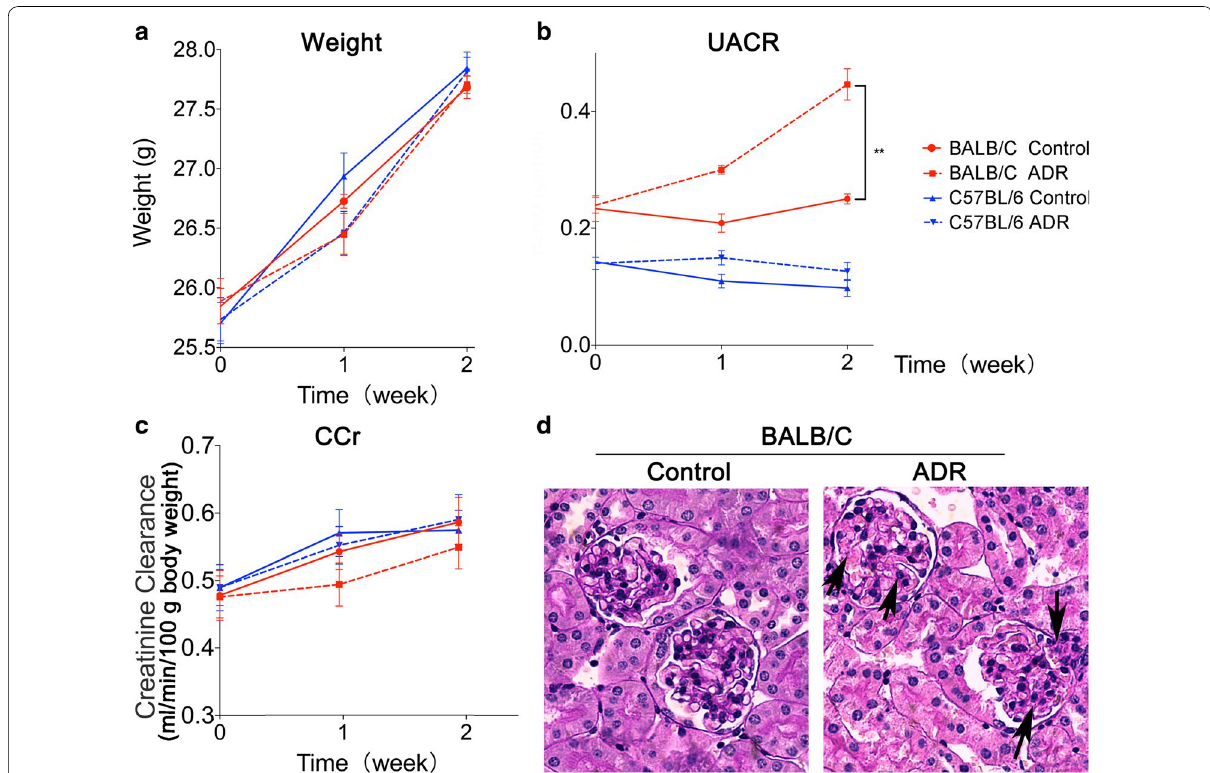
Fig. 1 BALB/C mice were sensitive to ADR. a The weight changes in the control and ADR group of different mice during the 2 weeks; b the UACR changes in the control and ADR group of different mice during the 2 weeks; c the CCr changes in the control and ADR group of different mice dur- ing the 2 weeks; d the nephridial tissue section of BALB/C ADR group and control group, glomeruli damage is indicated by filled arrows. **p <